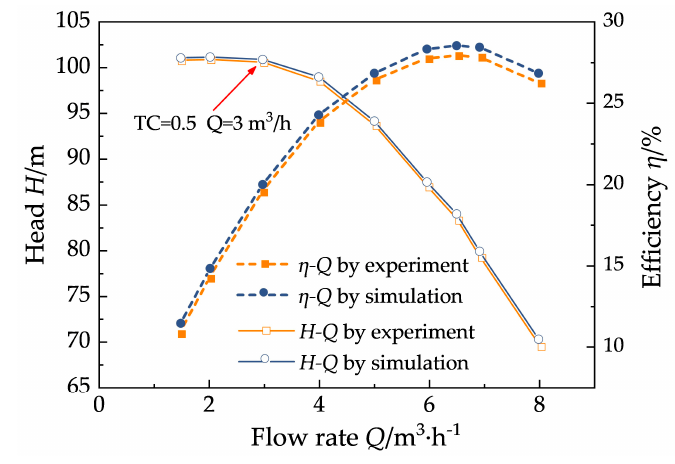
Figure 3. External characteristic curve.